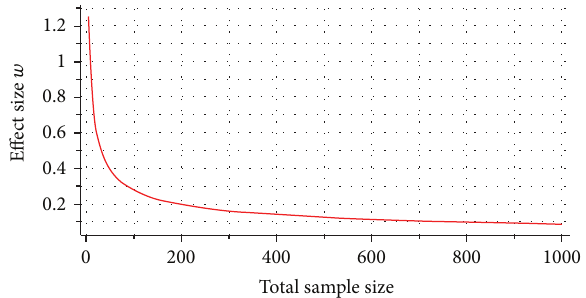
Figure 1: 𝜒 2 goodness of fit tests: contingency tables Df = 1, 𝛼 err prob = 0.05, and power ( 1 − 𝛽 err prob) =